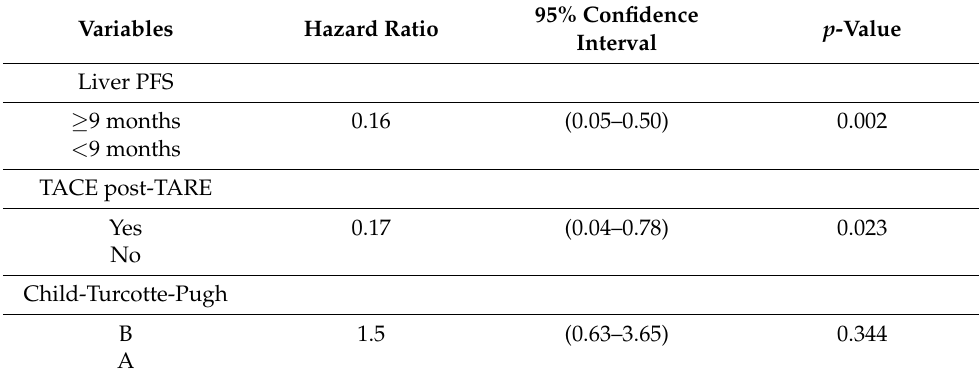
Table 5. Multivariate Cox proportional hazards analysis for OS from